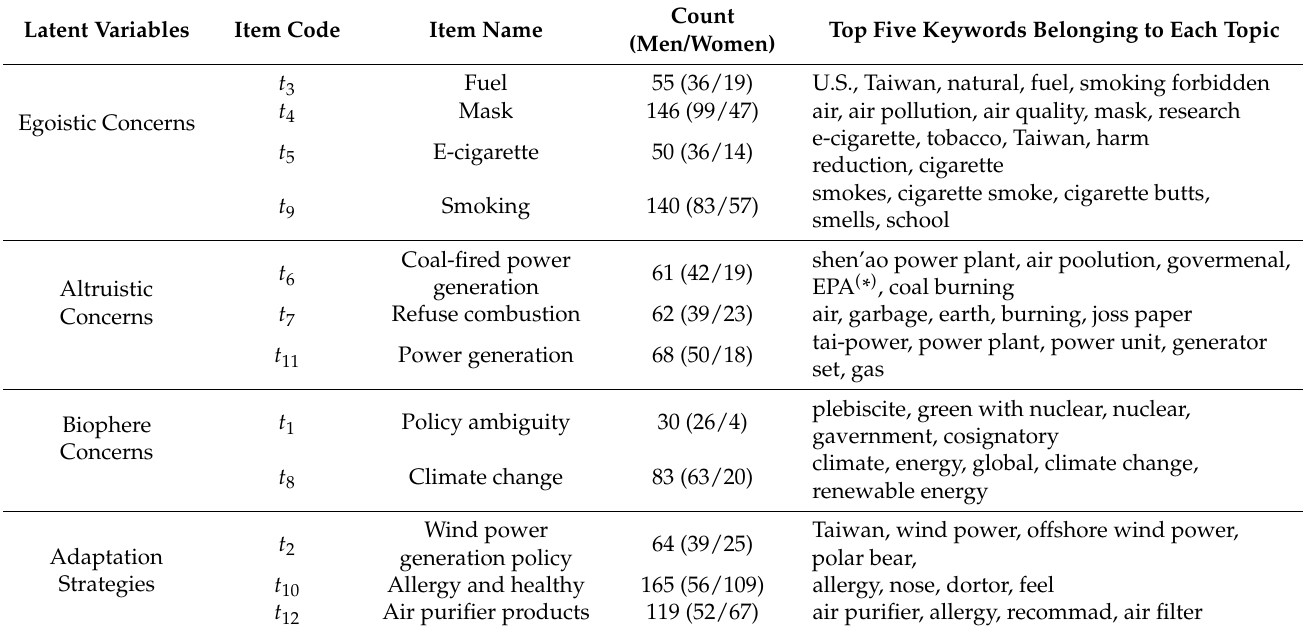
Table 1. Identified topics and topic